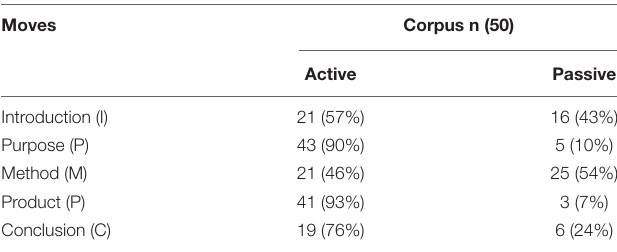
TABLE 4 | The voice used in the analyzed